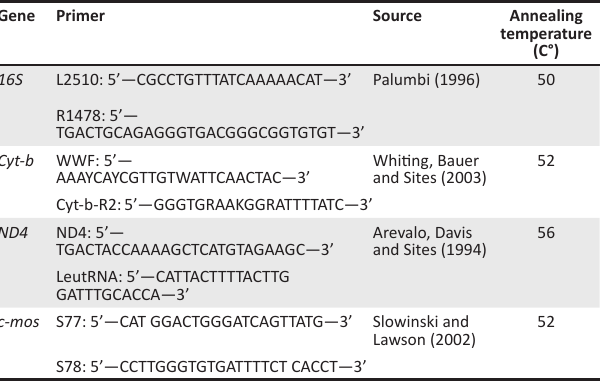
TABLE 1: Primers and PCR protocols used to generate sequences for the study. Gene Primer Source Annealing